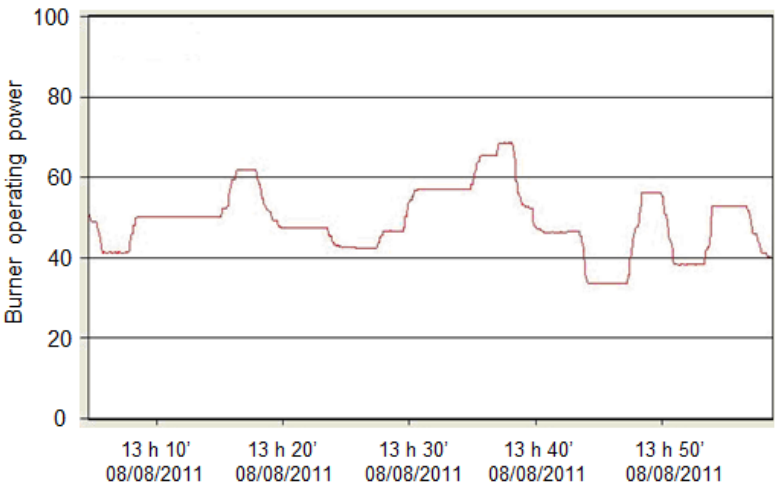
Figure 9. Boiler 5: Burner operating power (%), implementing actions 1 and 2.